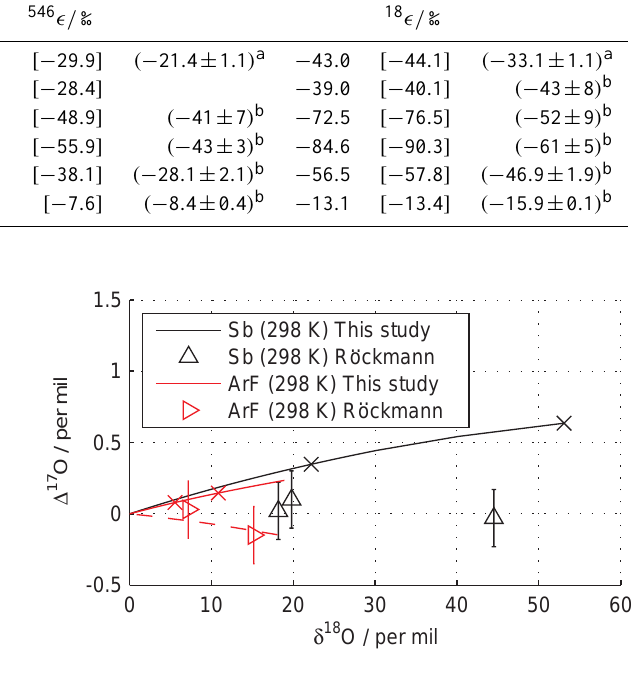
Fig. 6. The evolution of δ 18 O and 1 17 O as the fraction of remain- ing reactant ( f ) decreases. The δ 18 O and 1 17 O of this study are calculated using Eqs. (7) and (8). All lines run from f = 1 . 0 to 0 . 3 (i.e. from 0% to 70% conversion). The black × mark f = 0 . 6 and f = 0 . 3 while the red × mark f = 0 . 7 and f = 0 . 5. The exper- imental results of R¨ockmann et al. (2001b) are at about the same yield of reaction. The broken red line is monochromatic photolysis at